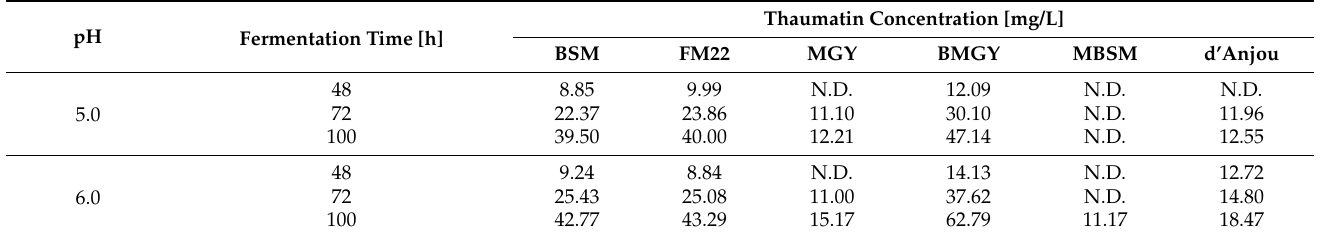
Table 1. Concentration levels of recombinant thaumatin II secreted into the media at pH 5.0 and 6.0 when grown in commonly used fermentation media at 30 °C and quantified using HPLC.